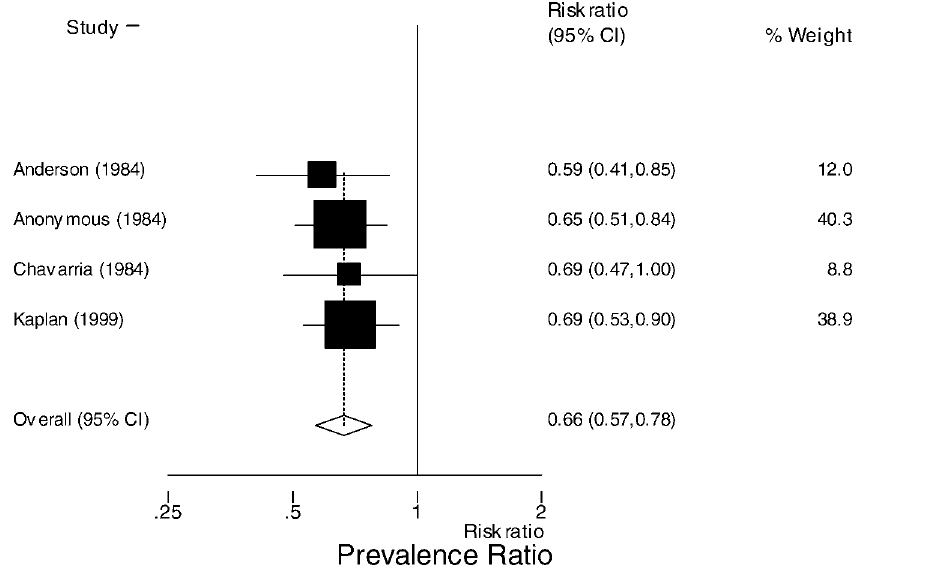
(Table 3). Using the random-effects method, the sub-analyses of the mean differences of diarrhea count at 24 h were no longer statistically significant in meta-analyses of studies that met all four indicators of methodological quality (Table 4).